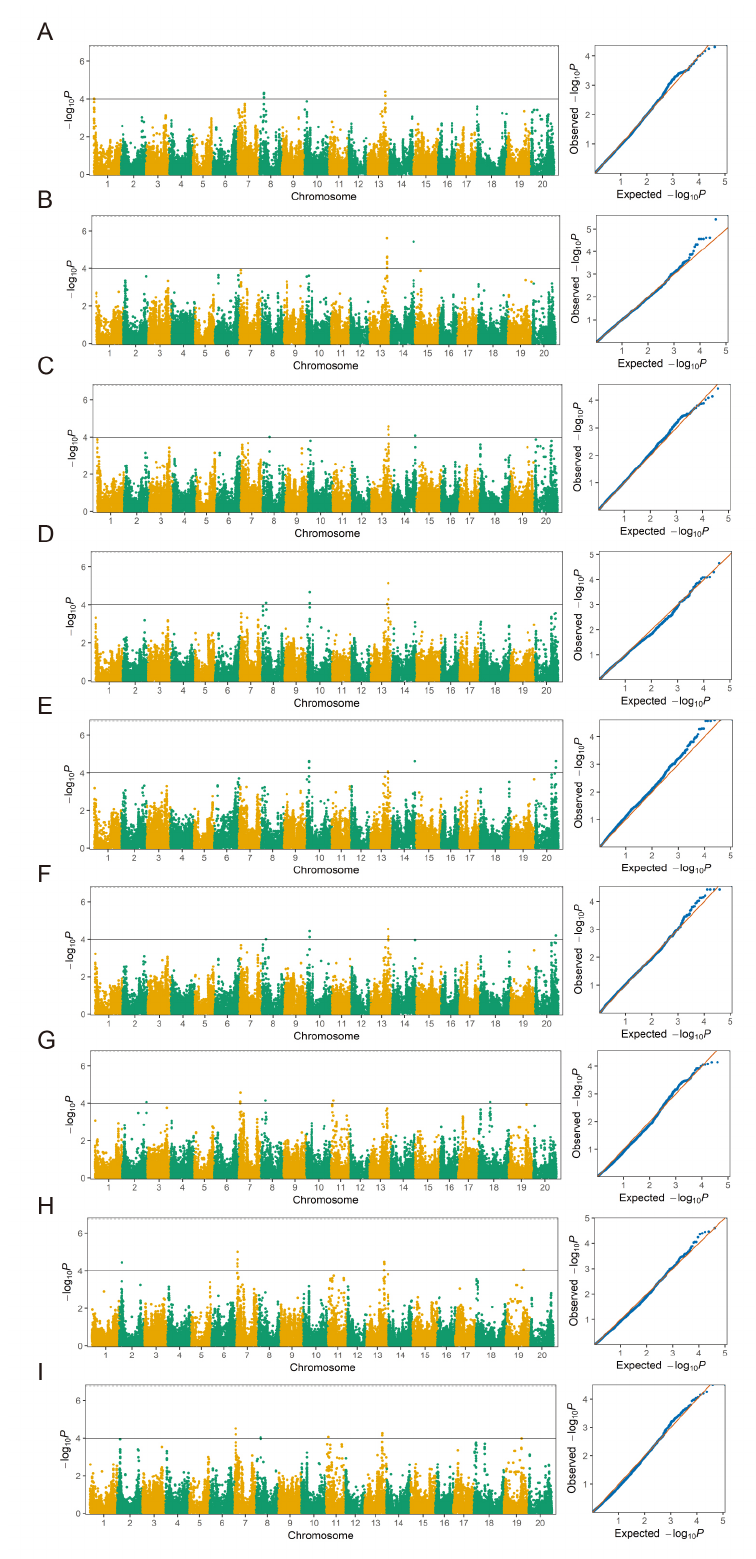
Figure 5. Genome-wide association study utilized in the population, including Manhattan plots and quantile-quantile (QQ) plots for ( A ) GR-JP14. ( B ) GR-HY15. ( C ) GR-Combined. ( D ) NSR-JP14. ( E ) NSR-HY15. ( F ) NSR-Combined. ( G ) EC-JP14. ( H ) EC-HY15. ( I )